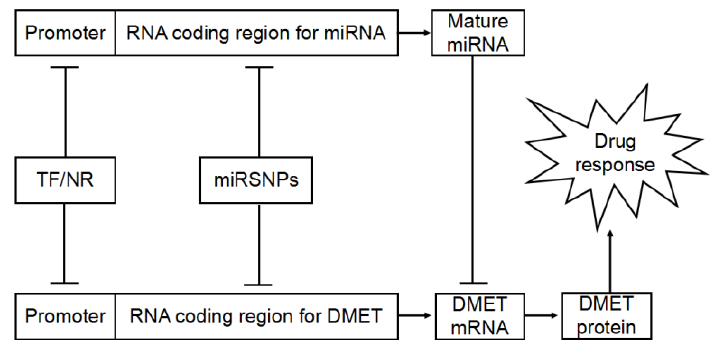
Figure 2. Interplay between miRNA-mediated posttranscriptional regulation of drug disposition related genes expression and drug response. DMET: drug-metabolizing enzymes and transporters; TF: transcription factors; NR: nuclear receptors.